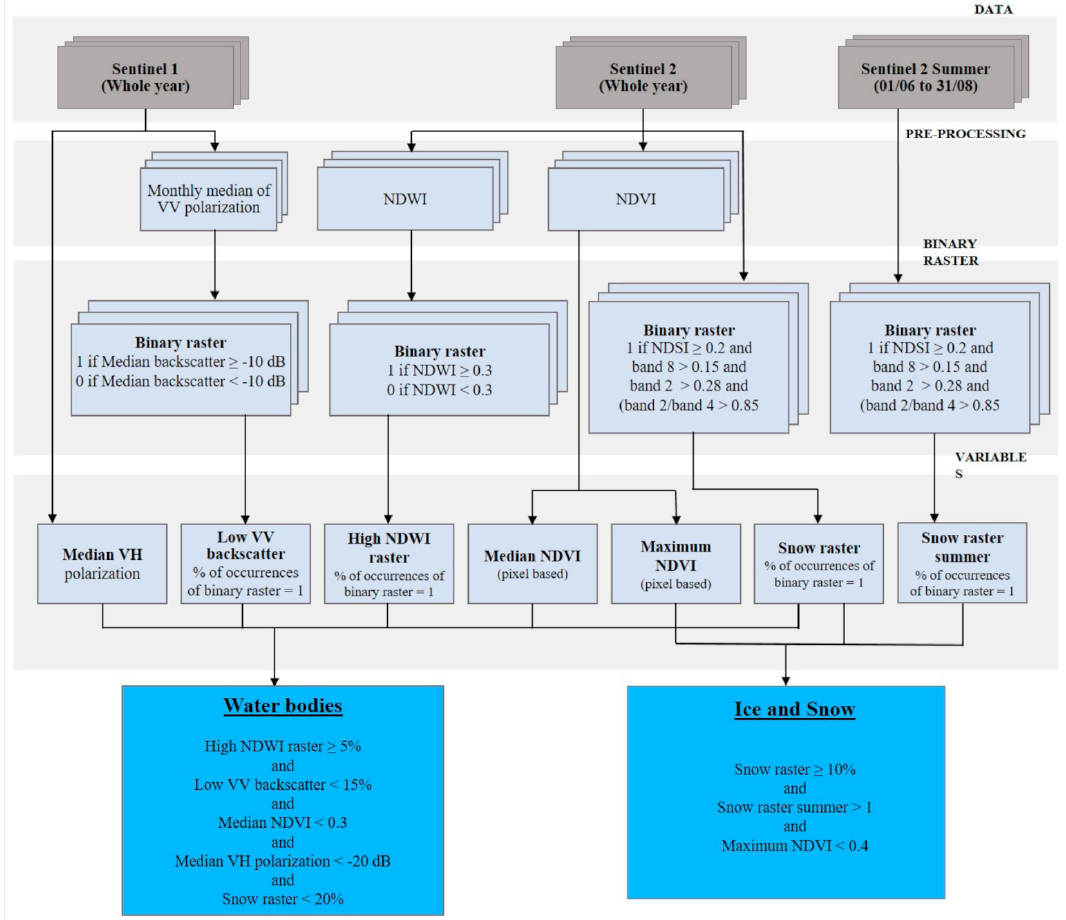
Figure A1. Workflow for water surfaces classification.